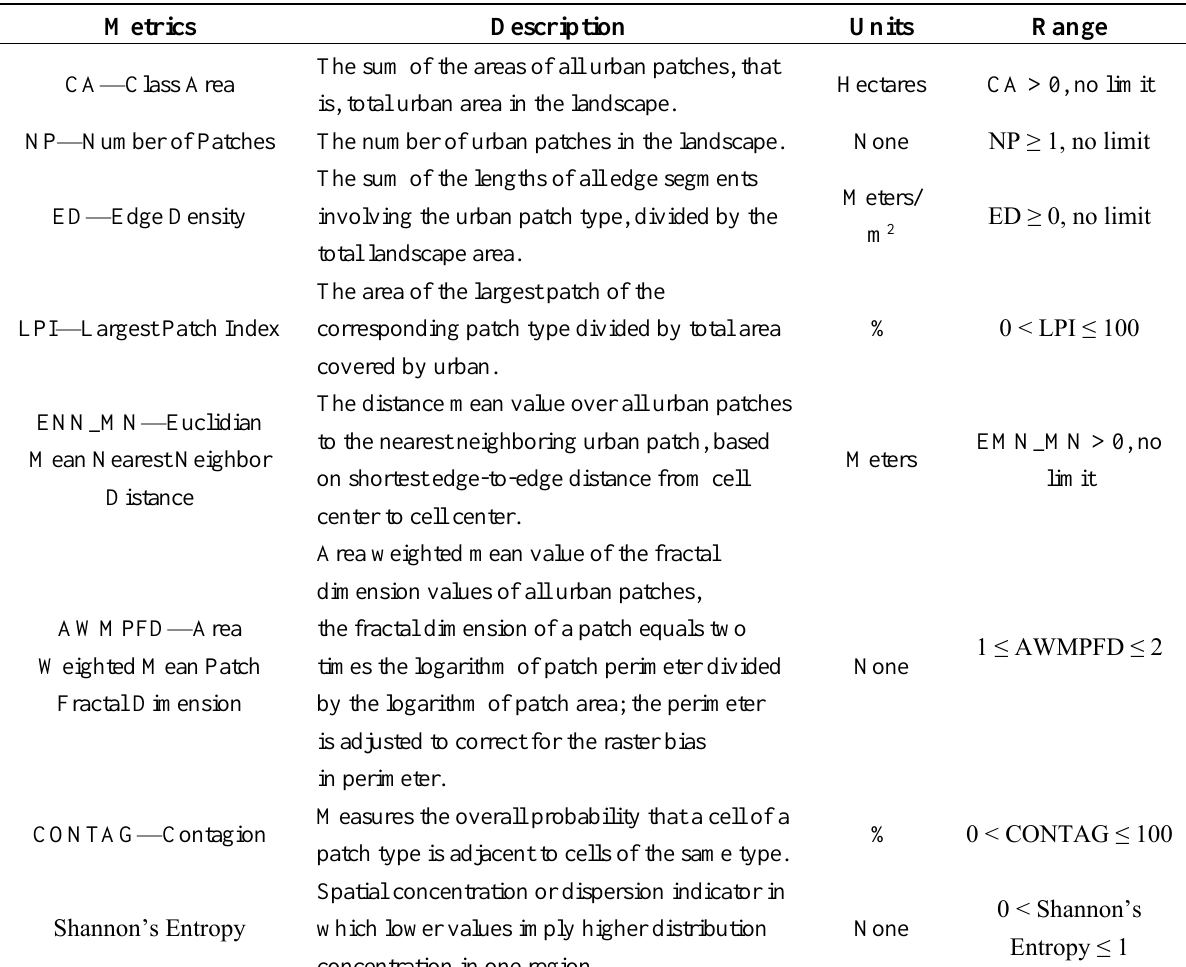
Table 3. Spatial